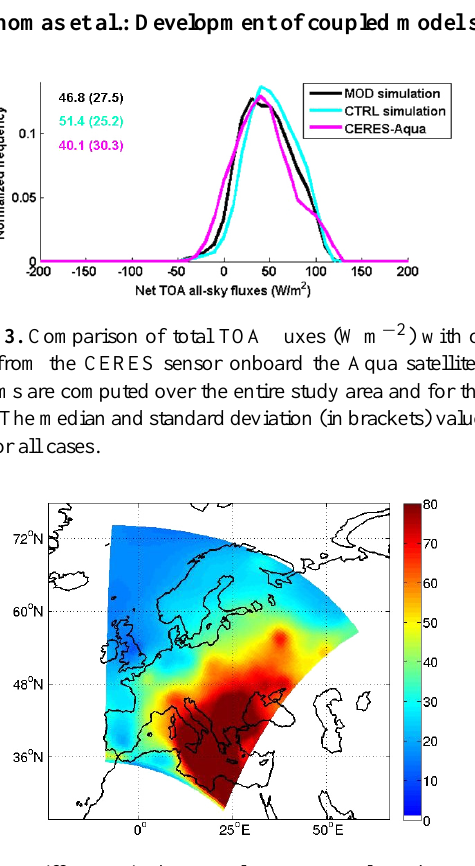
Figure 12. Difference in the annual mean total net fluxes (Wm − 2 ) at the TOA in the (MOD–CTRL) case.